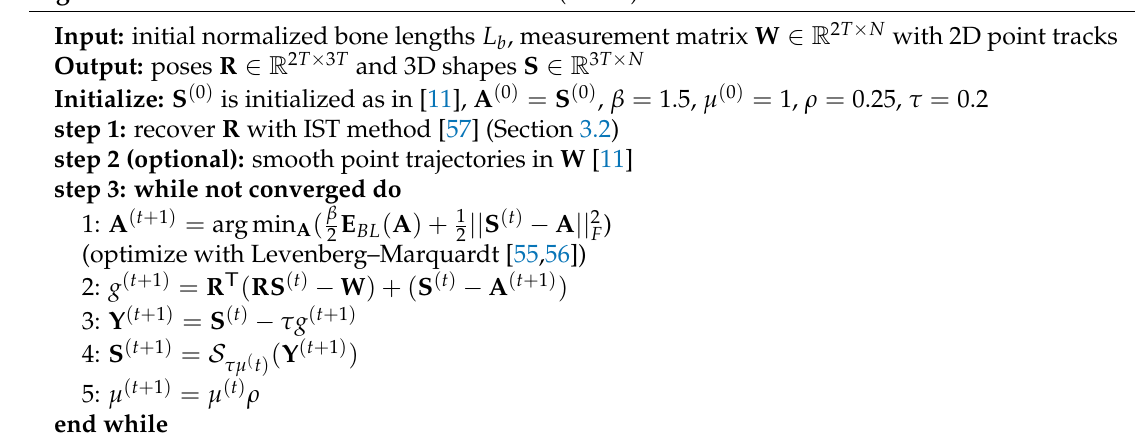
Algorithm 1 Structure from Articulated Motion